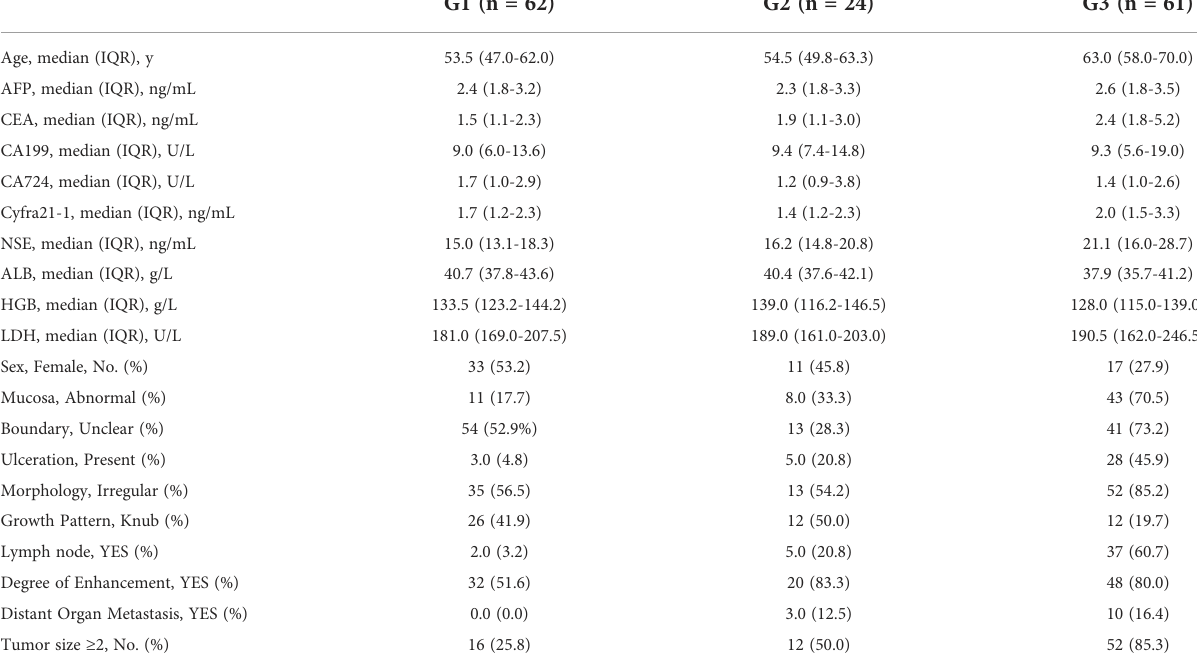
TABLE 1 Characteristics of patients with GI-NETs in the G1, G2 and 3